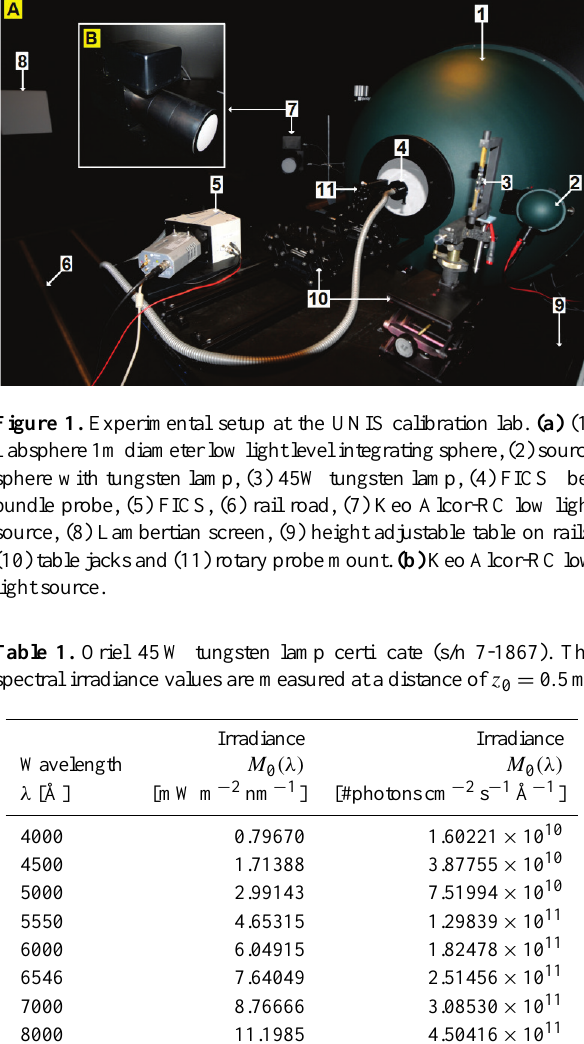
Figure 3. Absolute and wavelength calibration of the FICS. The line spectrum in red is from a mercury vapour lamp supplied by Edmund Optics Ltd (SN K60-908). The solid black spectra are from the Keo Alcor-RC certificate. The corresponding black dotted lines are spectra measured by the FICS. The spectrum of the integrating sphere is plotted in blue.